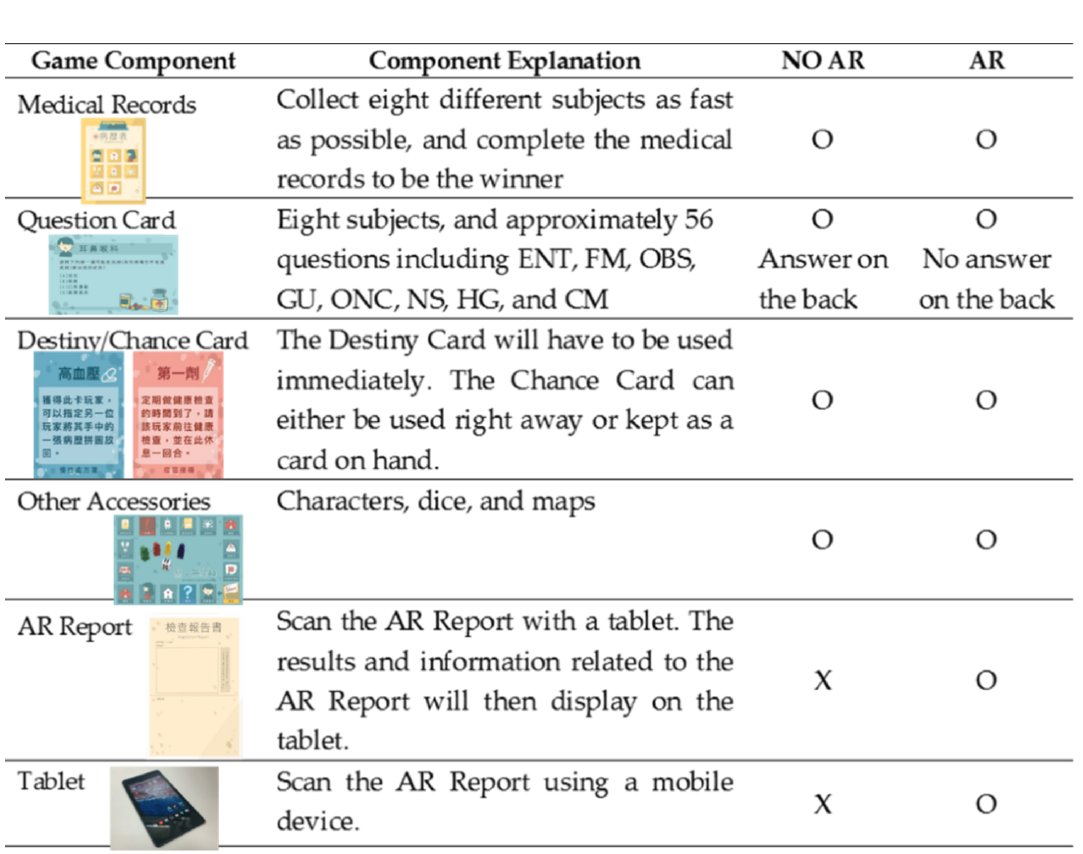
Figure 1. Components of augmented reality board game for health education.